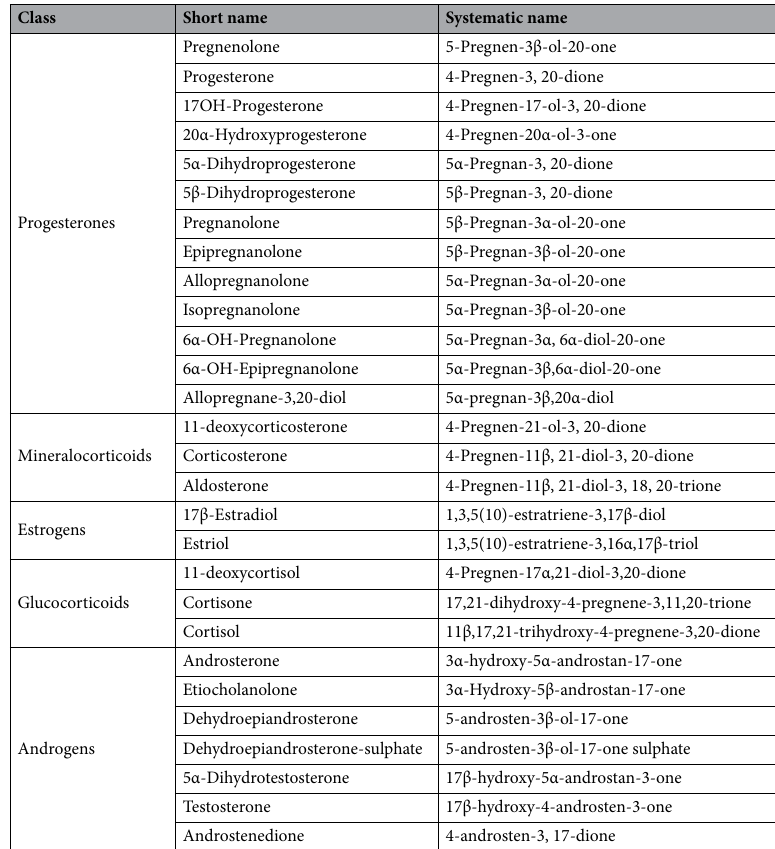
Table 7. List of all steroids analyzed or mentioned in this study with their short and systematic name.